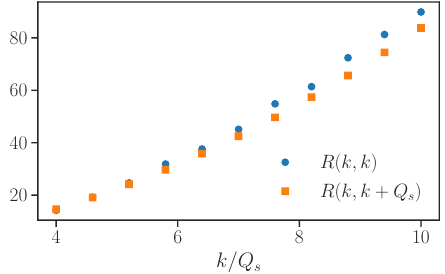
k 2 〉 / 〈 v 2 N 〉 as a function of transverse momentum. 2 2